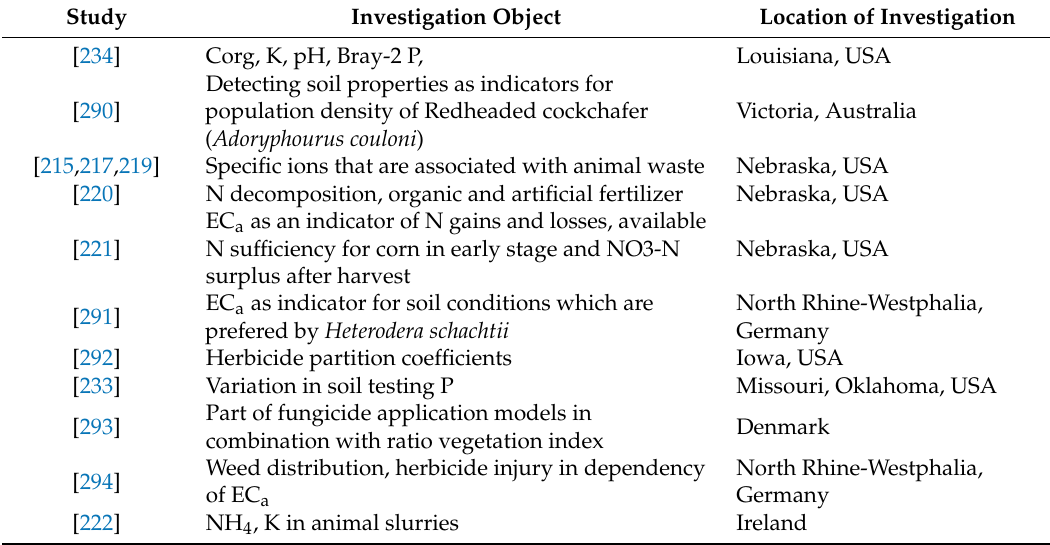
Table 10. Additional applications of EM38-EC a in agriculture and